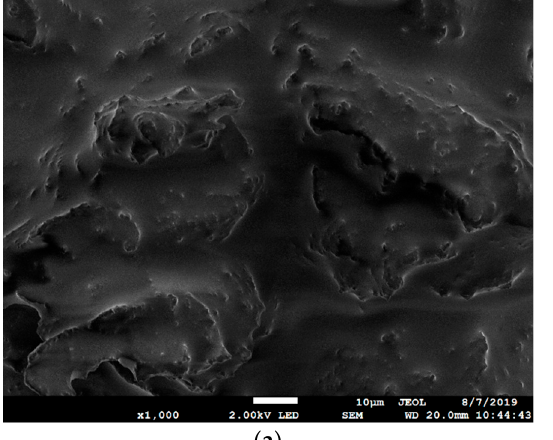
( c ) Figure 3. Scanning electron microscopy (SEM) of cells’ surface morphological alterations of the mamey seed samples by ( a ) non-extraction; ( b ) solvent extraction; and ( c ) aqueous enzymatic extraction. 3. Materials and Methods 3.1. Materials Mature mamey sapote fruits were purchased from a local market from Tuxtla Gutiér- rez, Chiapas, Mexico. The fruits were opened to obtain the seeds, and they were manually dehulled to extract the kernels, which were cut into thin slices and dried at 70 °C for 24 h (in an oven). After that, the dried slices were ground in a blender (Moulinex type 643), and then stored in amber flasks at 4 °C. Fatty acid methyl ester mixture (FAME MIX) standard and Viscozyme L was pur- chased from Sigma Aldrich, Mexico. Viscozyme L had a claimed the enzymatic activity of 120 fungal beta-glucanase units (FBGs) mL − 1 , in which 1 FBG is the amount of enzyme required under the standard conditions (30 °C, pH 5.0 and 30 min of reaction time) to hydrolyze barley β -glucan to reducing carbohydrates, with a reducing power correspond- ing to 1 μ mol glucose min − 1 (according to the supplier). Hexane, ethanol, and other chem- icals were of analytical or HPLC grade (supplied from J.K. Baker). 3.2. Solvent Extraction Solvent extraction (SE) was carried out according to the protocol recommended by the Association of Official Analytical Chemists (AOAC) [94]. Briefly, 200 mL of n-hexane and 5 g of ground mamey sapote kernel were placed in a Soxhlet extraction equipment at 95 °C for 8 h. After the oil extraction, hexane was eliminated using a rotary evaporator under reduced pressure at 50 °C. The extracted OMSS was dried at 70 °C for 24 h, and